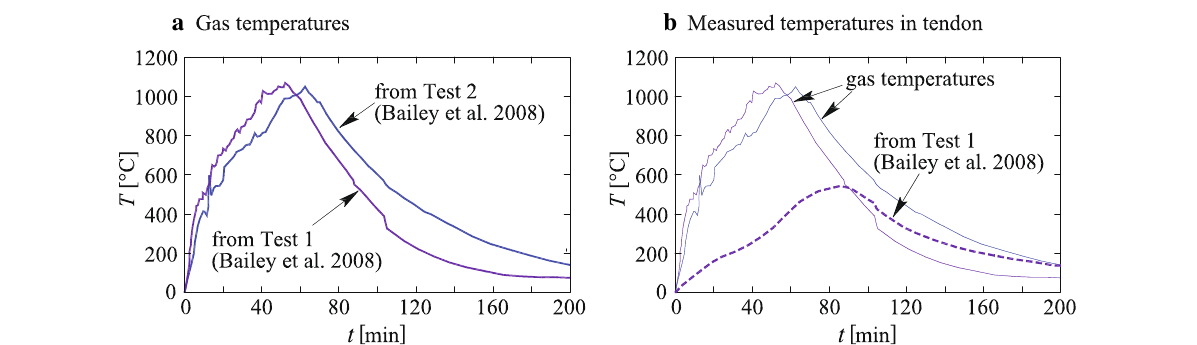
Fig. 5 a Development of gas temperatures in fire compartment for Test 1 and 2, b development of temperatures at the tendon location with time for Test